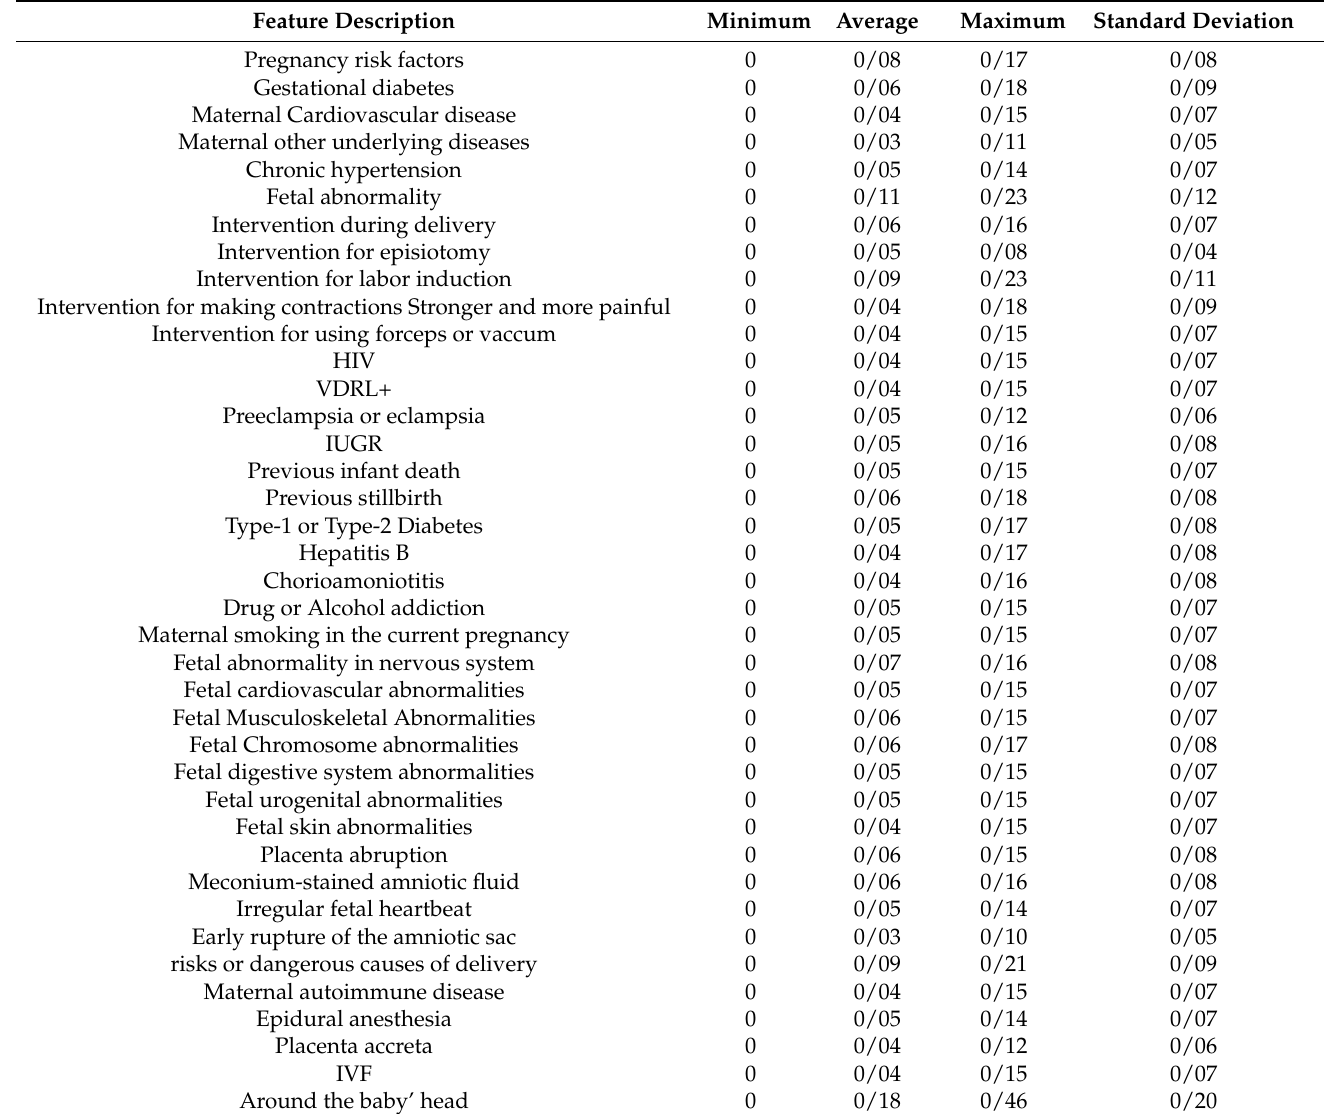
Figure 7. The feature scores obtained by complex network analysis in this study. Table 3. Summary statistics for feature scores assigned by four different ensemble feature scoring methods in this